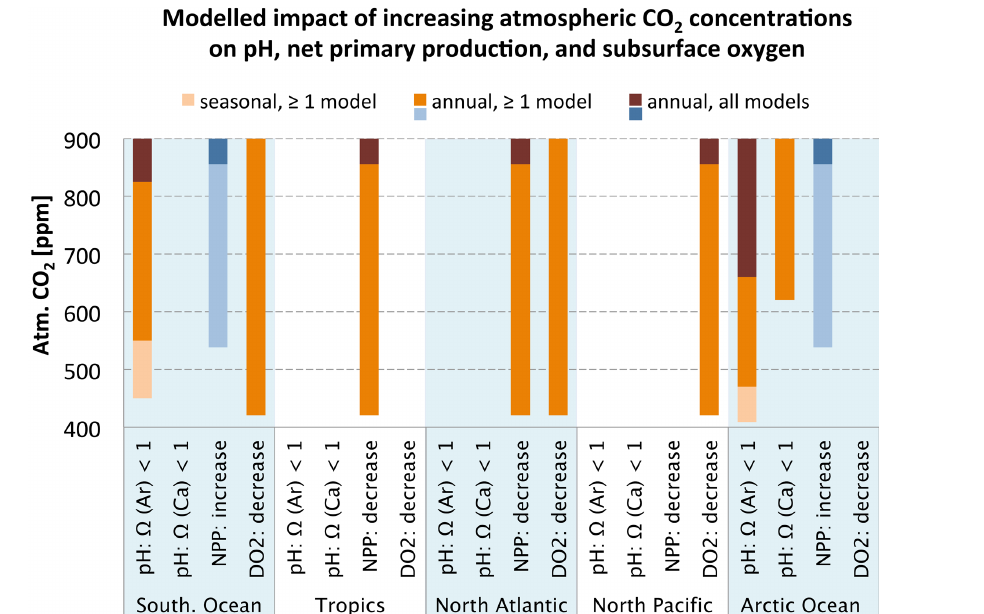
Figure 5. Modelled impact of increasing atmospheric CO 2 concentrations on stressors of ocean ecosystems, that is surface undersaturation of aragonite (pH: (cid:127) (Ar) < 1) and calcite (pH: (cid:127) (Ca) < 1), net primary production (NPP), and oxygen at 200–600m depth (DO2). Bright orange bars denote a seasonal development, while orange and light blue bars denote annual developments projected by one or more models. Red and blue bars indicate that all considered models agree on the depicted development. Orange and red bars denote furthermore a negative impact on marine ecosystems, while blue and light blue bars indicate an increase of the modelled parameter with the ecologic impact of this development not yet fully being determined. Impacts are based on a comprehensive suite of Earth system models and IPCC emission scenarios. The choice of models and scenarios is based on the IPCC AR5 report and references denoted within (Plattner et al., 2001; Orr et al., 2005; McNeil and Matear, 2008; Feely et al., 2009; Steinacher et al., 2009, 2010; Keeling et al., 2010; Bopp et al., 2013; Cocco et al., 2013). Note that DO2 and NPP are only analysed at the final year of the IPCC scenarios (year 2100), and their projected developments start most likely already at lower atmospheric CO 2